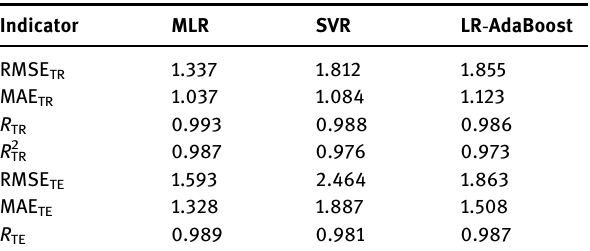
Table 5: The prediction results of the MLR, SVR, and LR - AdaBoost models